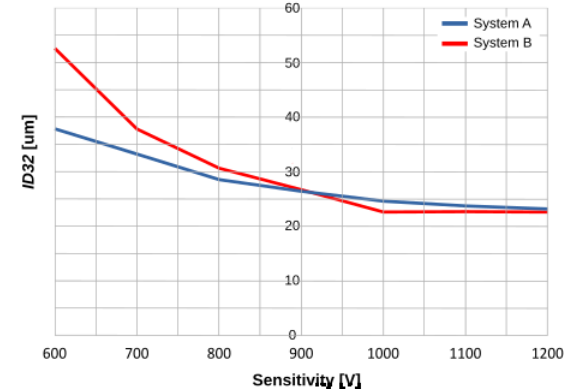
Fig. 6 . Systems compared by ID32 varying sensitivity of